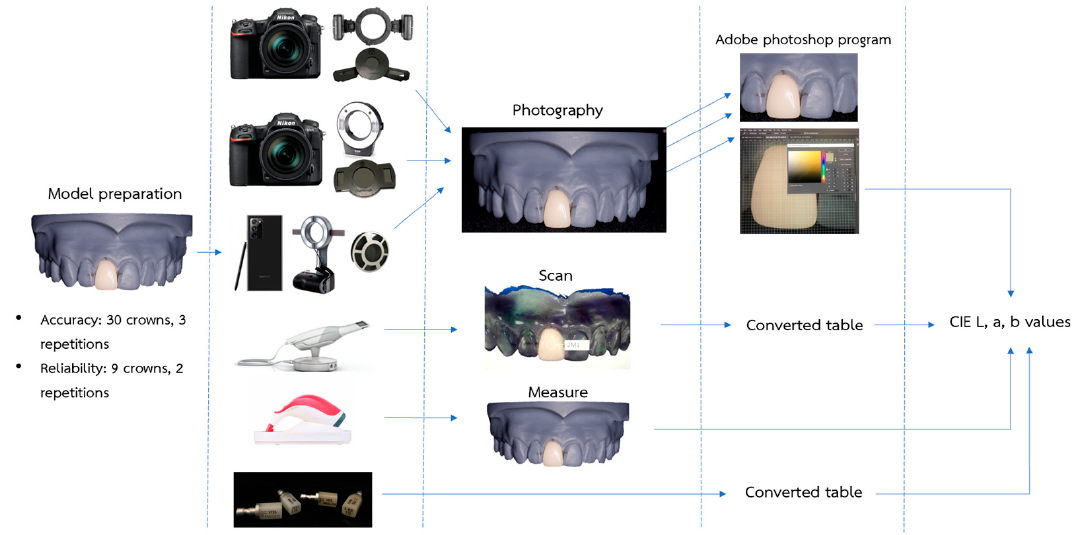
Figure 4. The details of the study. The CIE L, a, and b values were collected and used in data analysis.